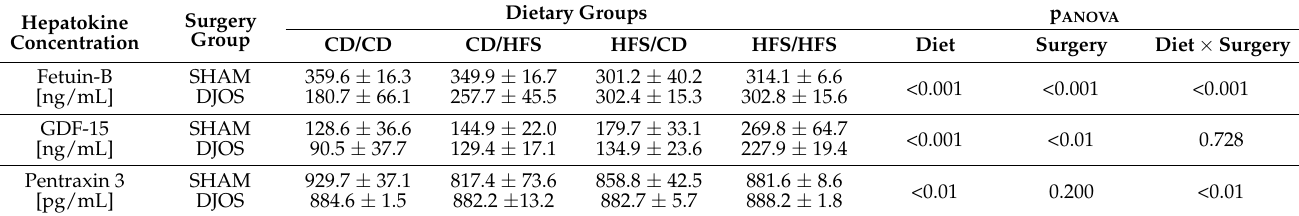
Table 5. Fetuin-B, growth differentiation factor-15 (GDF-15), and pentraxin 3 concentrations in plasma of Sprague–Dawley rats subjected to control (SHAM) and duodenojejunal omega switch (DJOS) surgery and different dietary regimes eight weeks after the surgery. The results are presented as mean ± standard deviation. Statistical significance was set at p < 0.05. Surgery Hepatokine Concentration